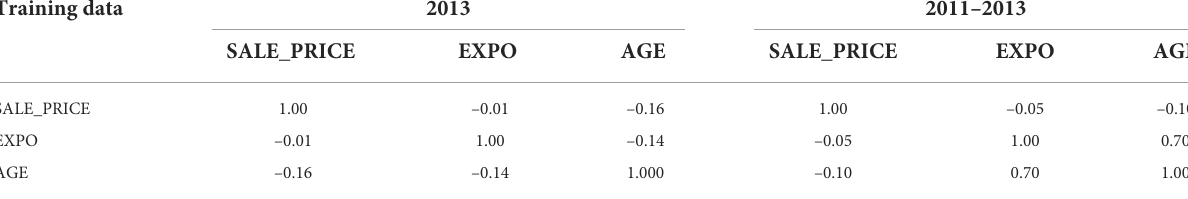
TABLE 4 Correlation matrix for SALE_PRICE, EXPO, and AGE for training data sets. Training